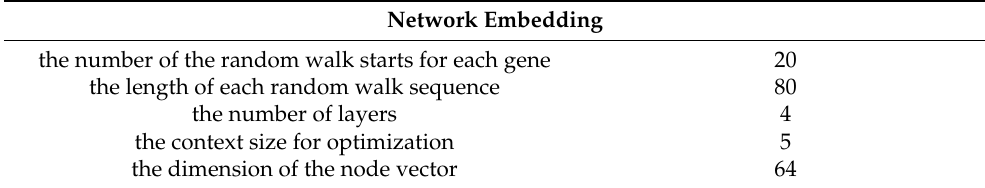
Table 1. The key parameters of the network embedding method.